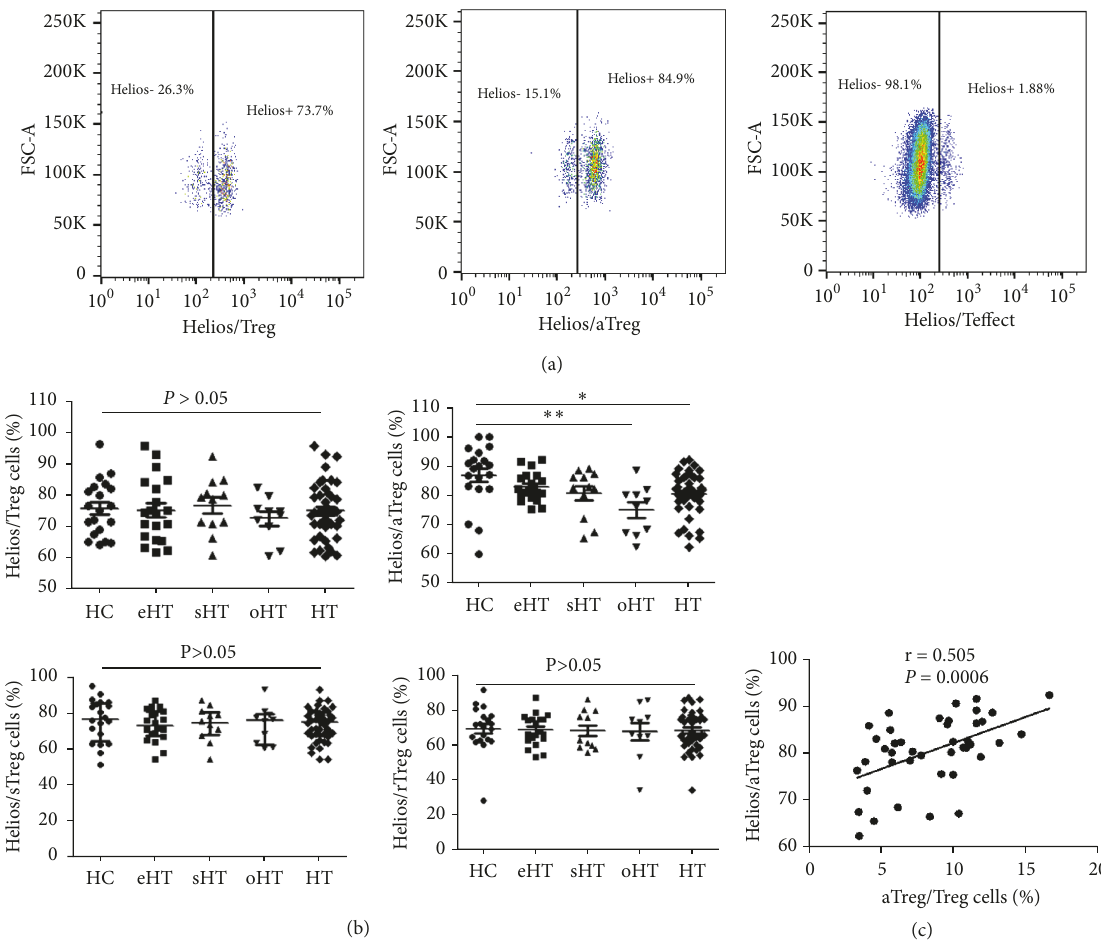
Figure 3: Helios expression in Treg cells. (a) Representative flow cytometric plots of Helios staining in Treg, aTreg, and Teffect cells from one HT patient.(b) Comparison of Helios expressing Tregs and subsets between differentstudy groups. (c) Correlationbetween Helios expression and aTreg cells from HT patients ( ∗ P < 0.05; ∗∗ P < 0.0075; ∗ ∗ ∗ P <